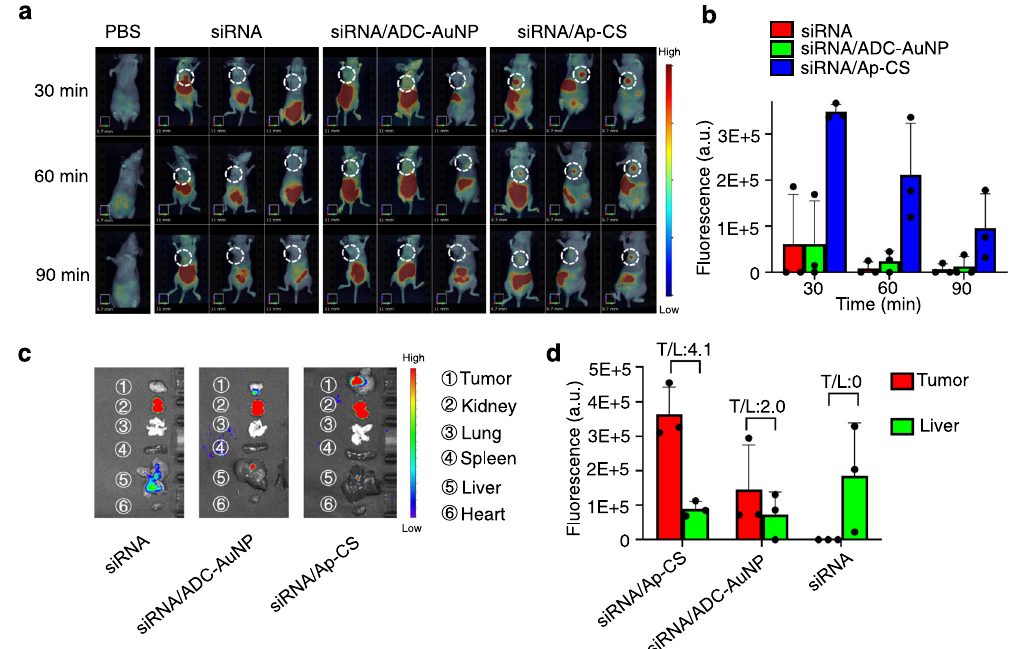
Fig. 4 In vivo biodistribution of siRNA/Ap-CS formulation. a Time-dependent in vivo fl uorescence imaging to explore the whole-body biodistribution kinetics of siRNA/Ap-CS and its tumor localization. A549 tumor-bearing BALB/c nude mice were used, and the samples, including PBS, siRNA, siRNA/ ADC-AuNP, and siRNA/Ap-CS, were administrated to the mice via tail vein injection. b The fl uorescence intensity of tumor sites in the white circles in panel a. The error bar represents the standard deviation (SD). The measured data are expressed as the means± SD ( n = 3). c Fluorescence images of the organs harvested at 90-min post injection of siRNA/Ap-CS, accompanied by the quantitative assessment of fl uorescence intensity from liver and tumor ( d ) where the fl uorescence ratio of tumor-to-liver (T/L) is also presented. The PS-ADC ( Plk1 sense partly complementary to ADC) and PA-Cy5 (Cy5- labeled Plk1 antisense) were used for the preparation of siPlk1 duplex. The error bar represents the standard deviation (SD). The measured data are expressed as the means ± SD ( n =